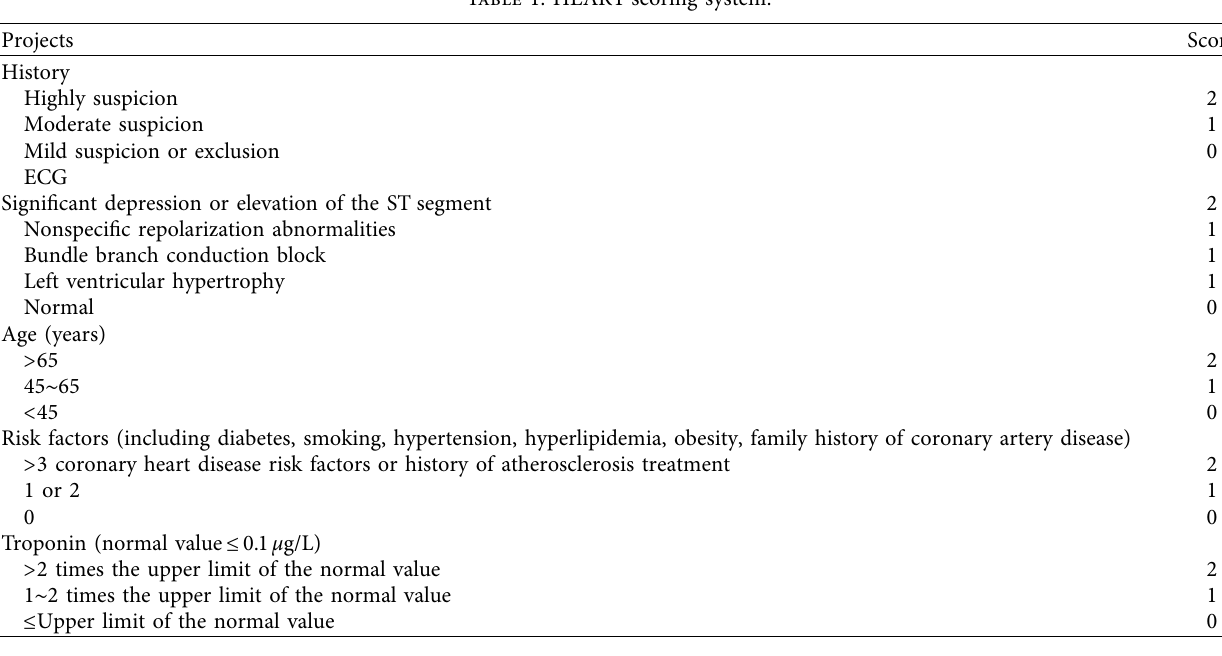
Table 1: HEART scoring